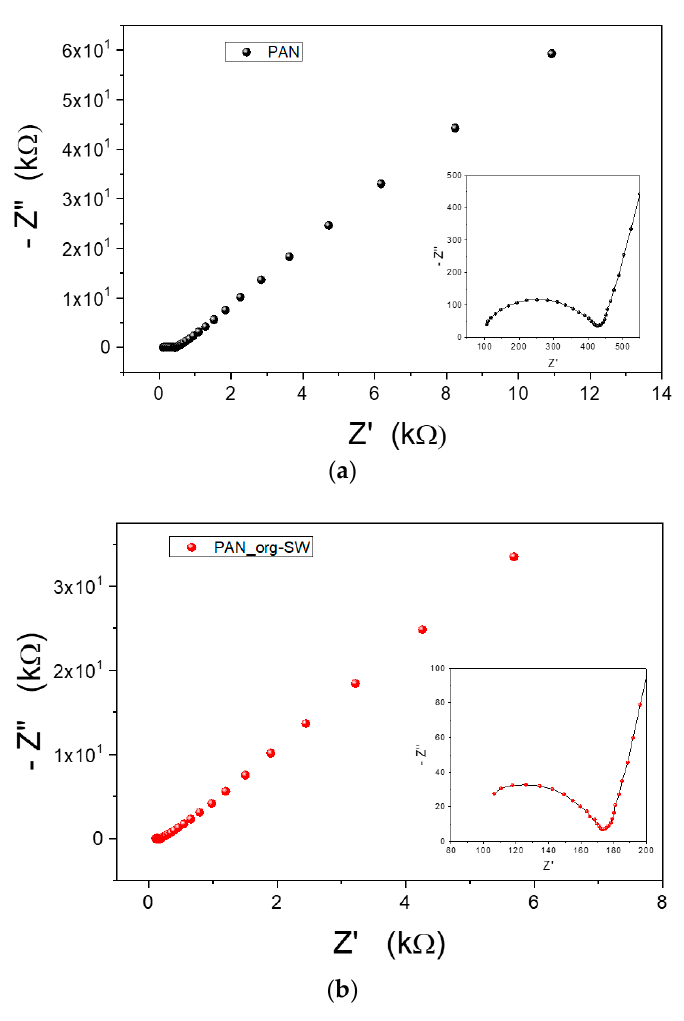
Figure 5. Nyquist plots of the impedance measured for PAN gel ( a ) and PAN/org-SWy nanocomposite gel ( b ). nanocomposite gel ( b ).